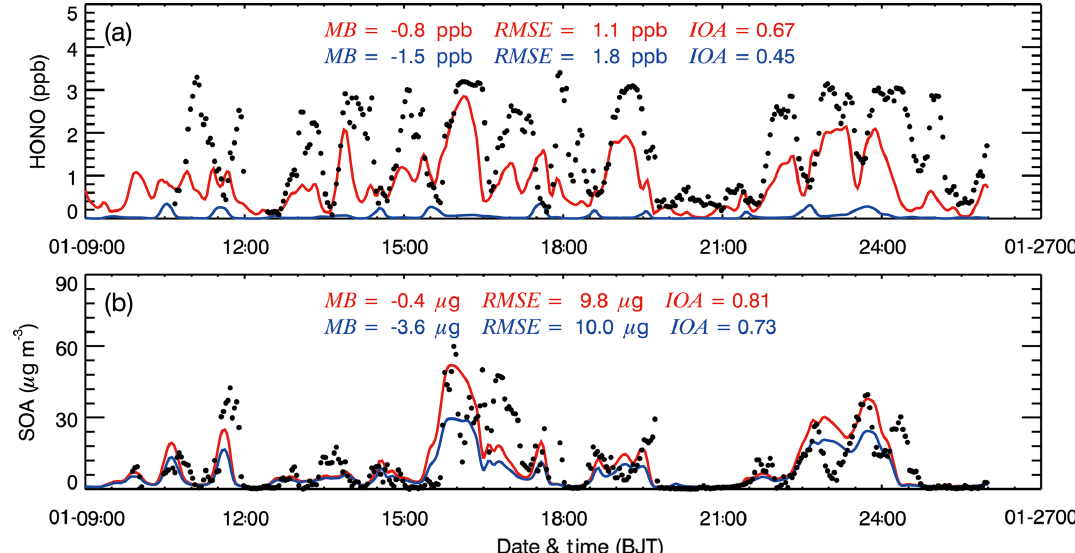
Figure 4. Comparisons of observed (black dots) and simulated (solid red and blue lines for the BASE and HOMO cases, respectively) diurnal profiles of near-surface hourly mass concentrations of (a) HONO and (b) SOA at the IRSDE site in Beijing from 9 to 26 January 2014. time (BJT, UTC+8) and 15 January 2014, respectively.